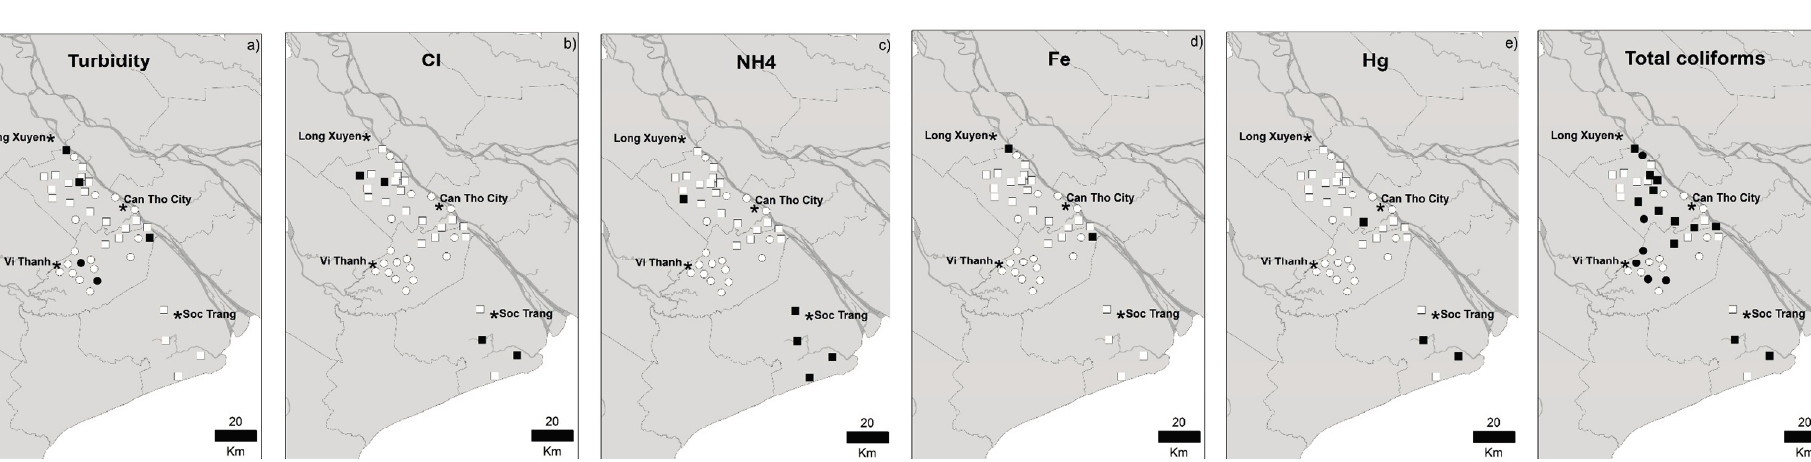
Figure 2. Spatial representation of water supply stations exceeding drinking water guidelines indicated by black boxes and dots for ( a ) turbidity level; ( b ) chloride; ( c ) ammonium; ( d ) total iron; ( e ) mercury; and ( f ) total